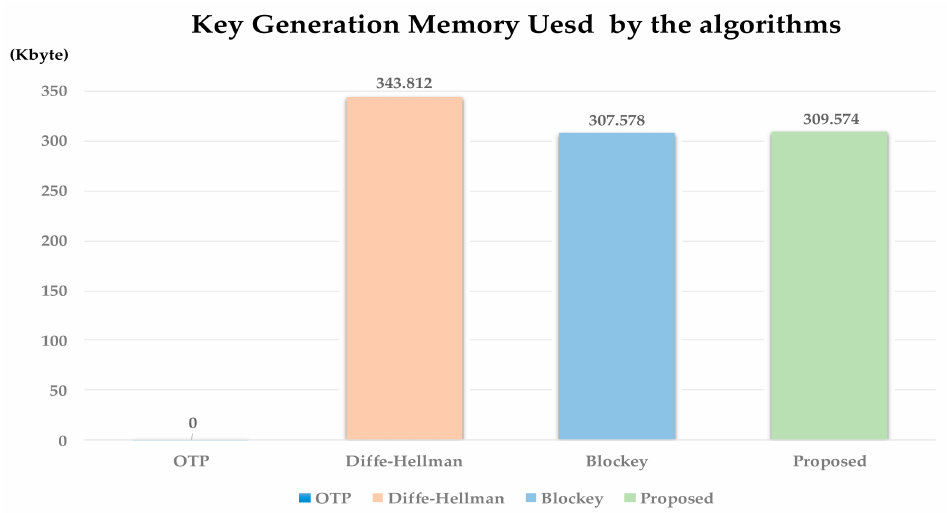
Figure 13. Experiment result of Section